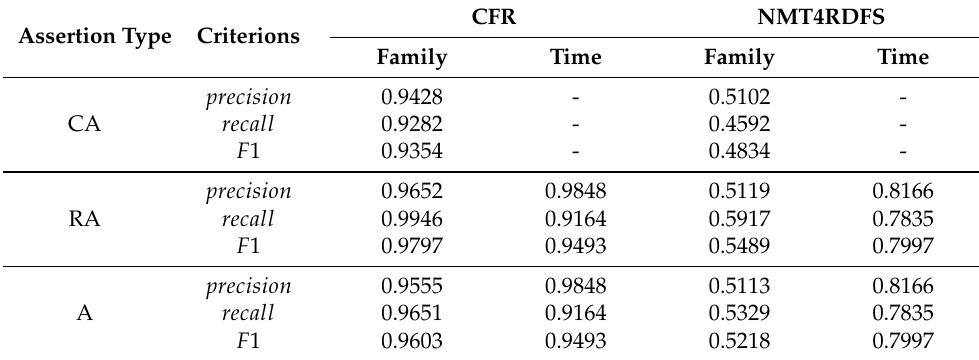
Table 5. The precision , recall and F 1 of class assertions (CA), role assertions (RA) and all assertions (A) of the CFR and